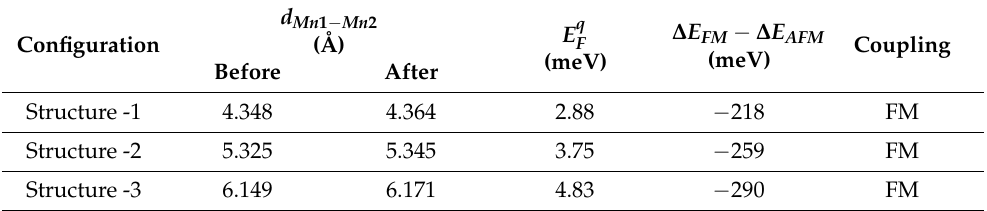
Table 1. Calculated energy ∆ E between FM and AFM for two (Mn +2 )-doped 3C-SiC supercells, in the 1, 2, and 3 structures. measured in meV and formation energy E q F